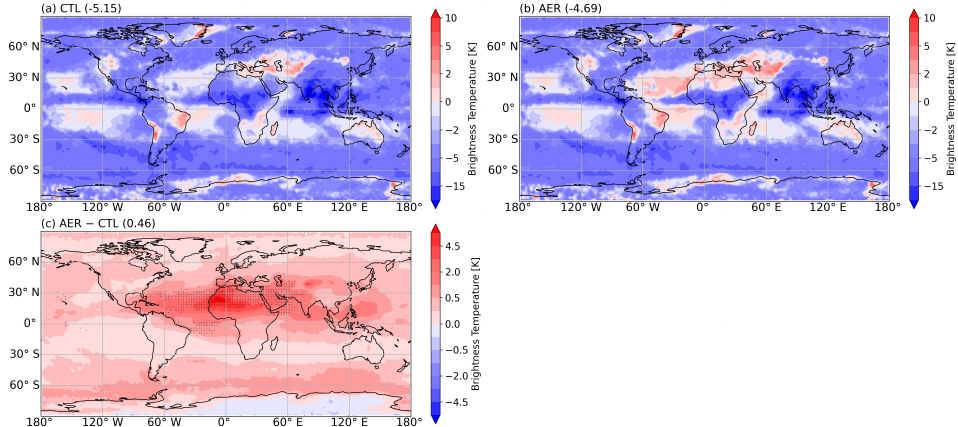
Figure 5. Comparison of first-guess departures before BC and QC at 10.39 µm from IASI on MetOp-A ◦ ◦ gridded at 2.5 by 2.5 over 1–28 August 2017. ( a ) CTL ( b ) AER ( c ) differences (AER minus CTL). Stippling in ( c ) indicates the difference is 99% significant ( p ≤